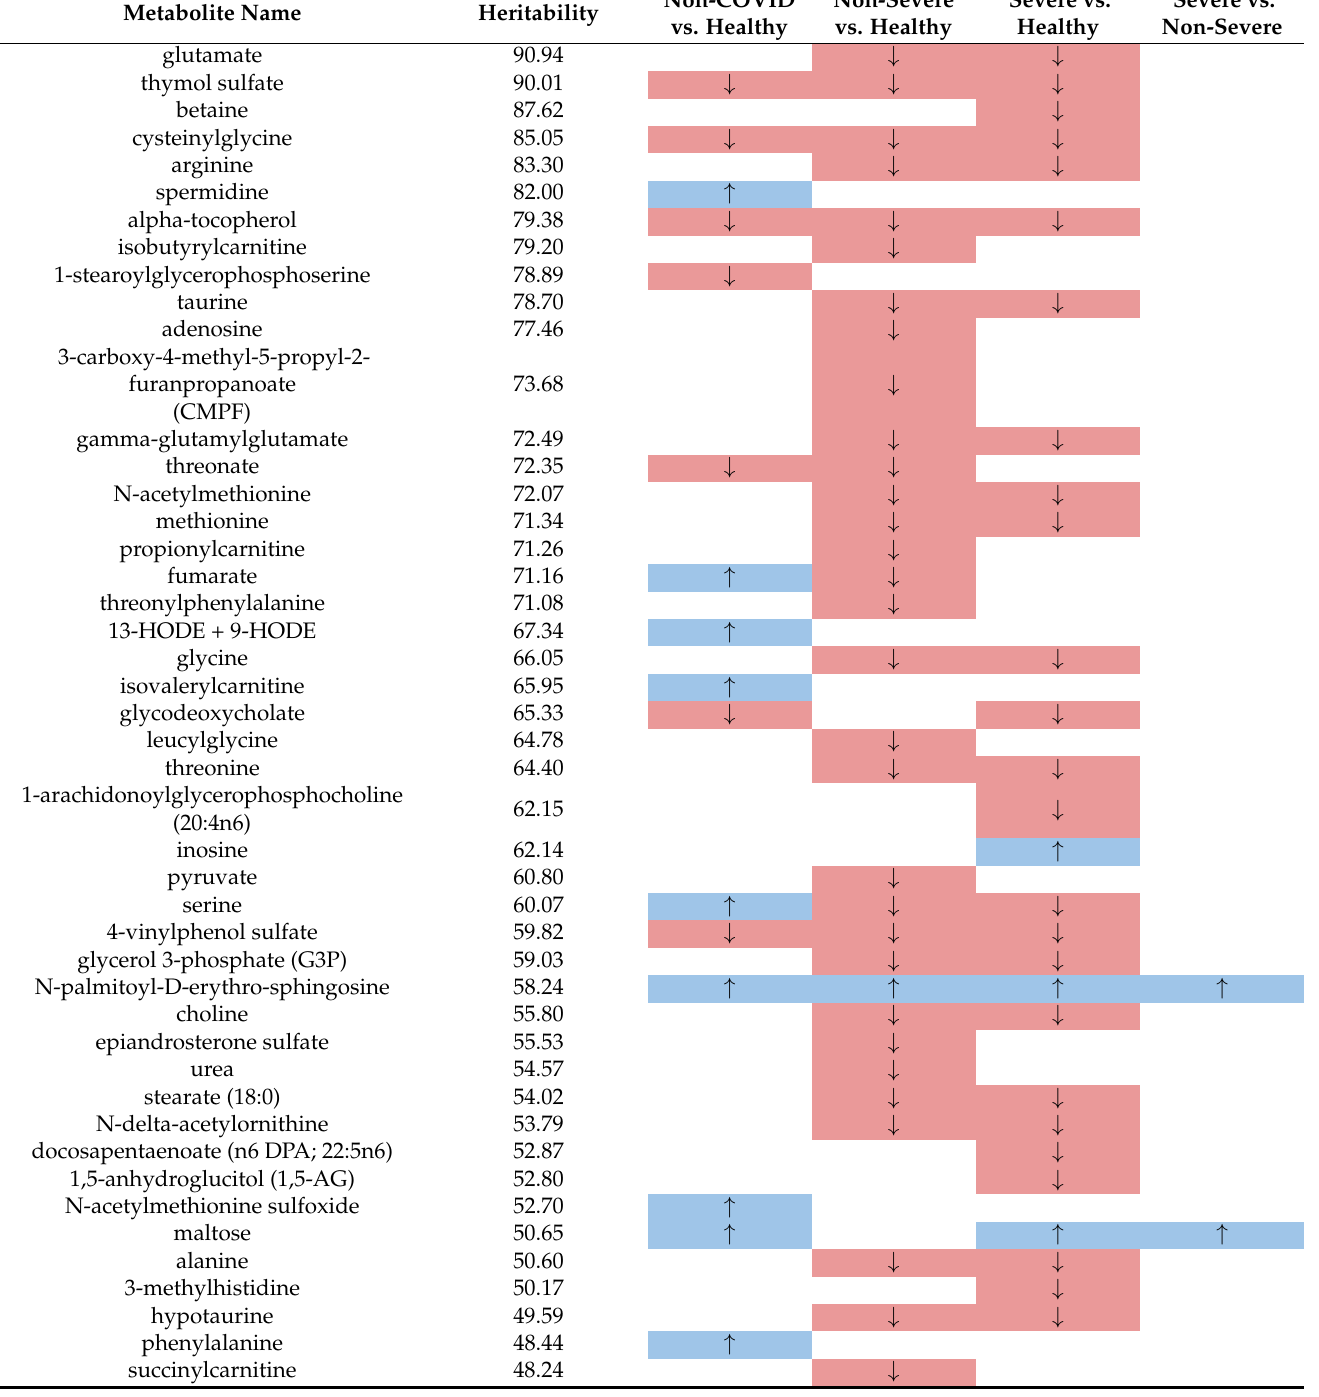
(Table 1). Using proteomics data from both [8,9], we identified 13 differentially expressed proteins having ≥ 30% heritability in erythrocytes (Table 2). Table 1. Heritable metabolites differentially expressed in COVID-19 disease states. Metabolites with ≥ 30% heritability in erythrocytes were identified. ↑ /blue indicates upregulation in the associated disease state (non-COVID-19, non-severe COVID-19, and severe COVID-19) in the [9] dataset; ↓ /red indicates